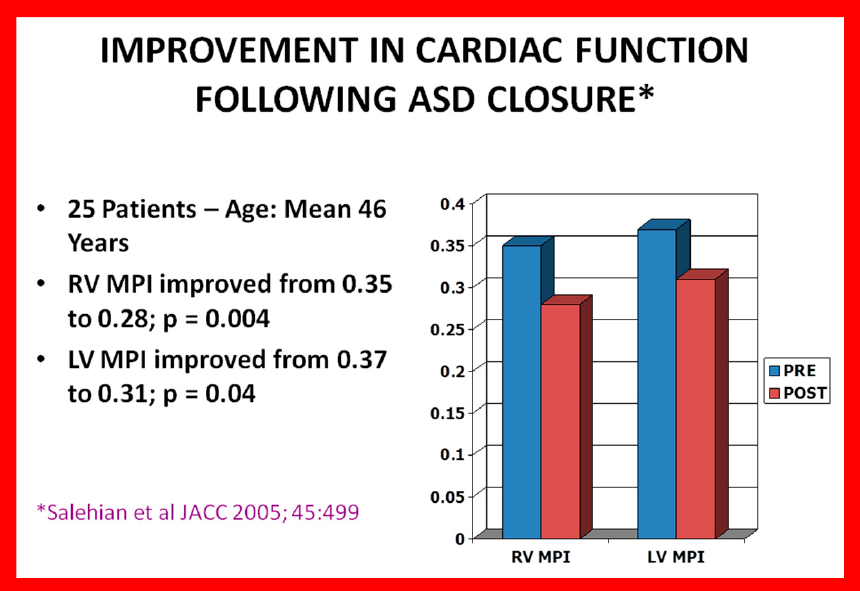
Figure 38. Enhancement of myocardial performance indices (MPI) of right ventricle (RV) and left ventricle (LV) after occlusion of atrial septal defects (ASDs) is illustrated in the above bar diagram. PRE, prior to ASD occlusion; POST, three months following ASD occlusion. Created from